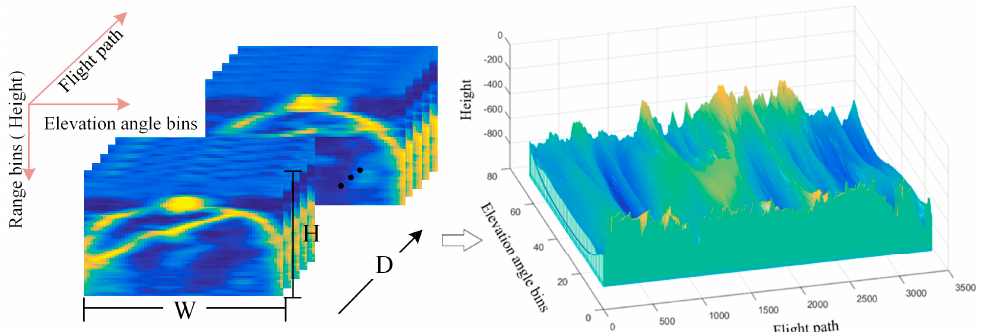
Figure 4. Illustration of a segment of 3D radar topology sequences ( left ) and a 3D sub-glacial terrain ( right ) reconstructed from the sequence. H and W are the height and width of each topology slice, respectively, and D is the number of slices in a segment.